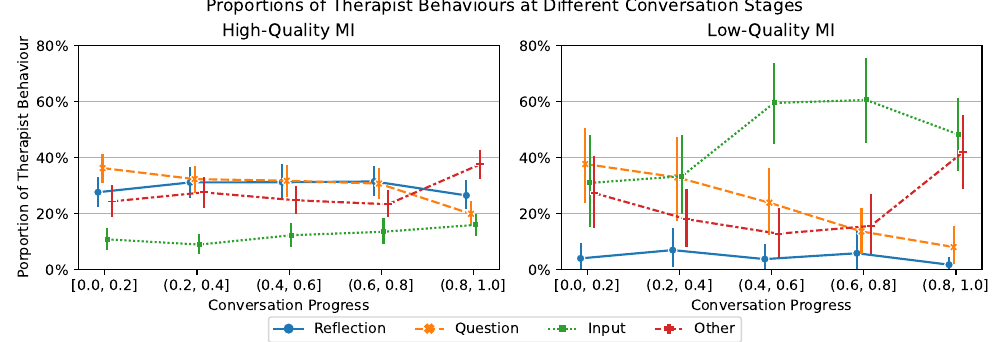
Figure 5. Proportions of therapist behaviours in different conversation stages in high- and low- quality MI. The marked data points are sample means, and the error bars around them are calculated using bootstrapping with a 95% confidence interval.